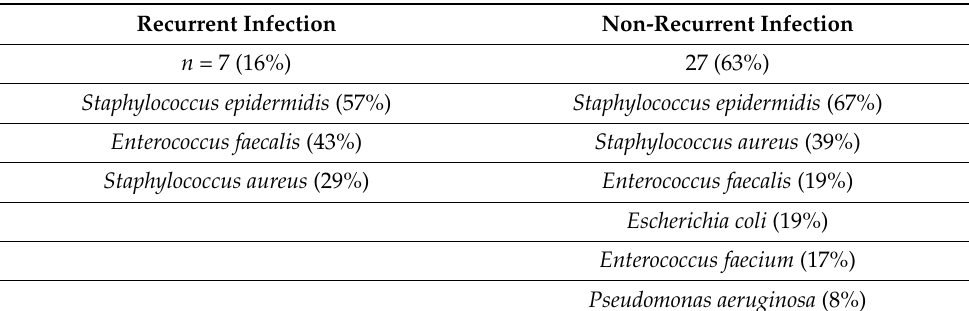
Table 2. Most frequent causing bacteria of implant-associated infections after pelvic surgery related to recurrence of infection in long-term follow-up. Note that polymicrobial infections were found in almost two thirds of the